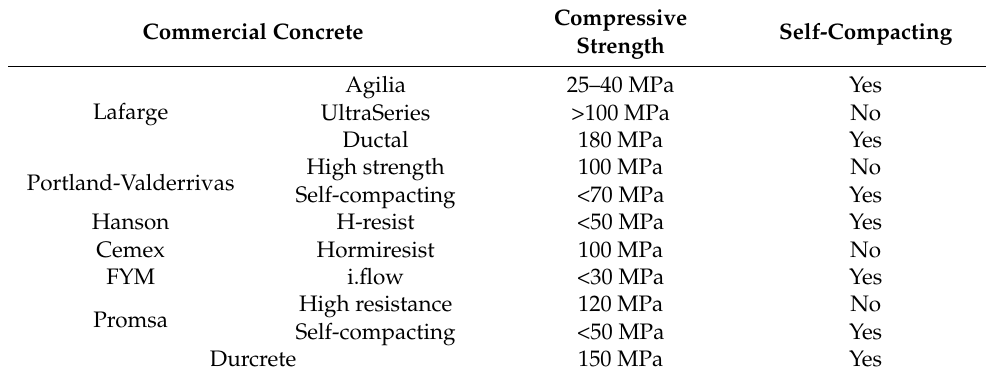
Table 1. Properties of commercial